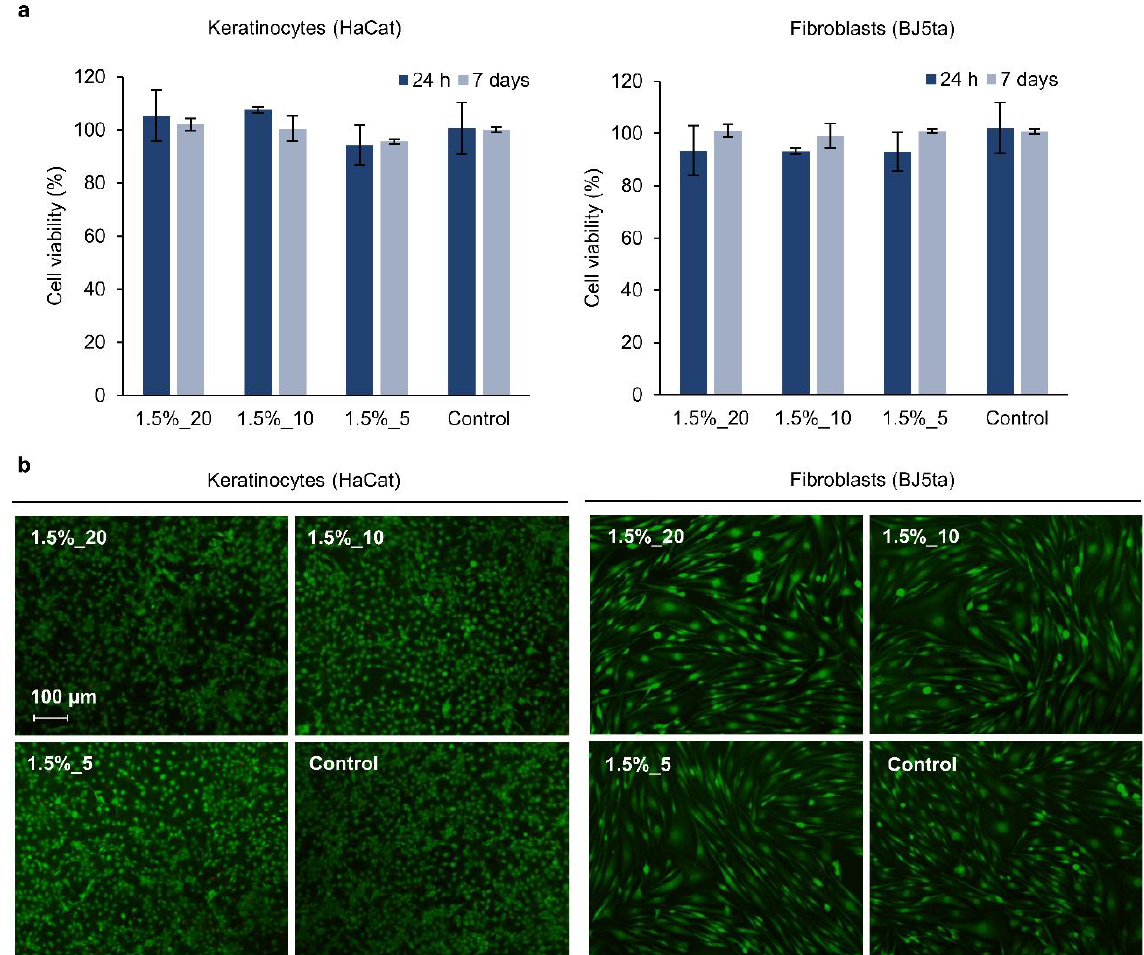
Figure 7. ( a ) Cell viability (%) of human keratinocytes and fibroblasts incubated with hydrogels (1.5%_20, 1.5%_10, and 1.5%_5) for 24 h assessed by the AlamarBlue assay. Results are reported as mean values of cell viability (%) ± SD (n = 3), and their statistical significance was calculated using a one-way ANOVA ( p < 0.05). ( b ) Live/dead assay of human keratinocytes and fibroblasts treated with the hydrogels for 7 days. The assay stains the live cells green and the dead ones red.